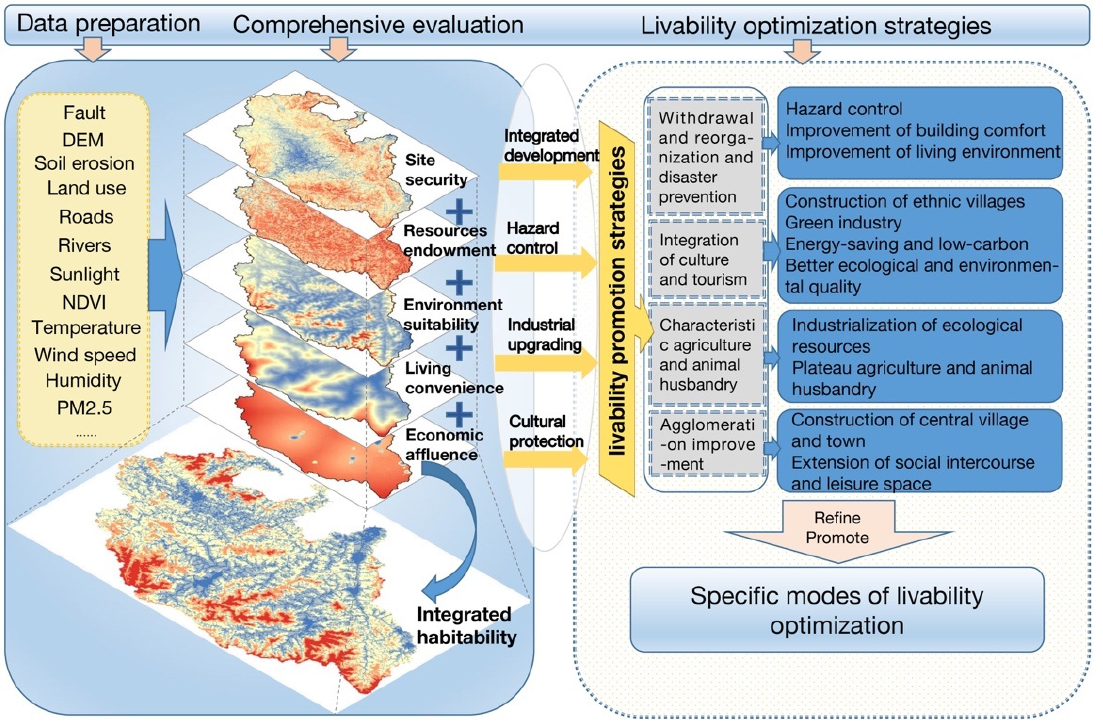
Figure 2. Evaluation and Optimization Framework of Rural Settlement Livability.